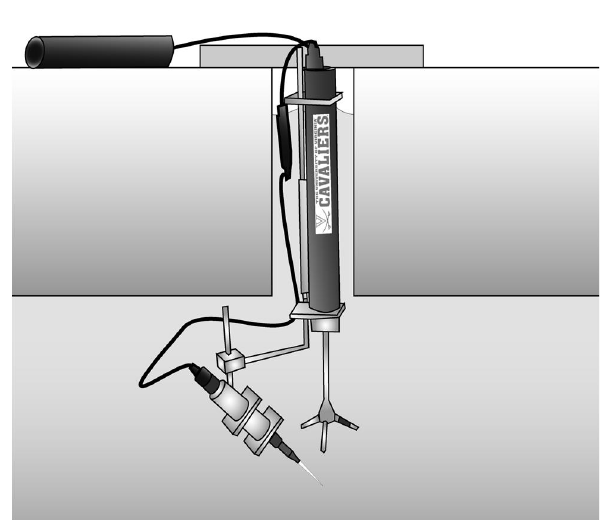
Fig. 1. Eddy correlation instrument deployed under sea-ice through a rectangular-shaped hole and secured with a T bar at the ice-air in- terface. The instrument may freeze into the ice but the power supply (top left) and communication port (top center) remained accessible from